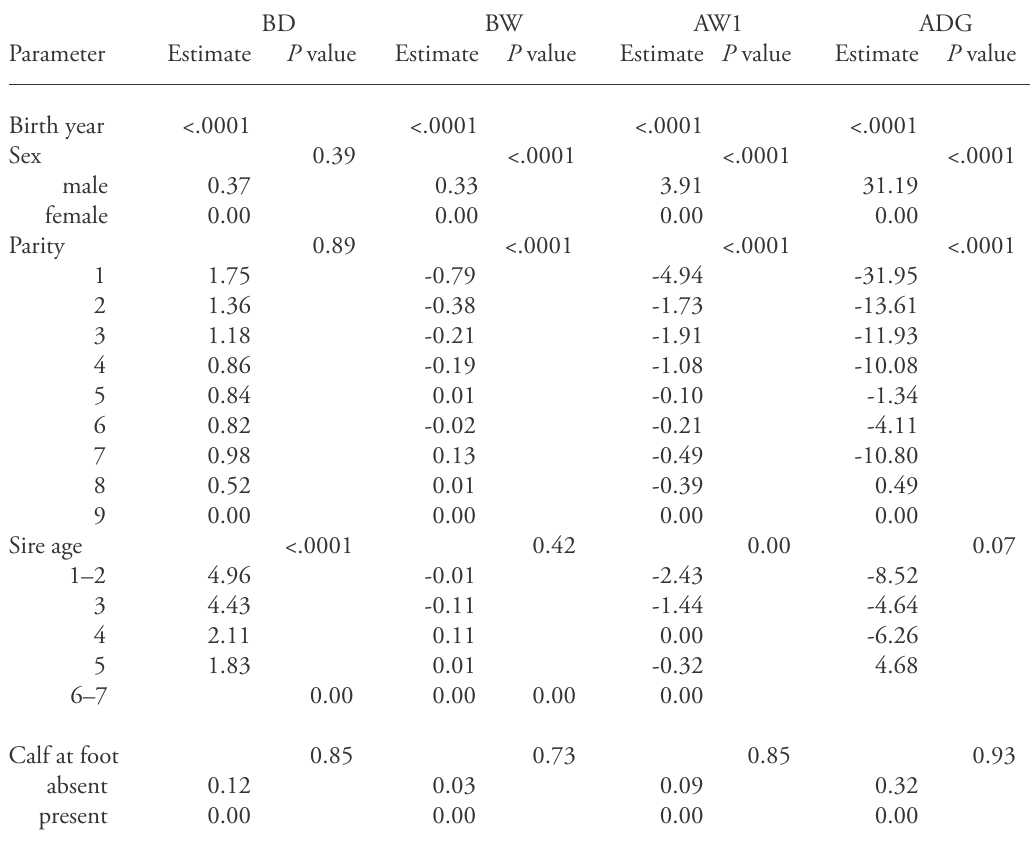
Table 2. The significance (F test) of fixed effects for birth date (BD), birth weight (BW), calf autumn weight (AW1) and average daily gain (ADG) in the Kutuharju reindeer herd in 1987-2011. The estimated level values of fixed effects (except year) are expressed as deviations from the last